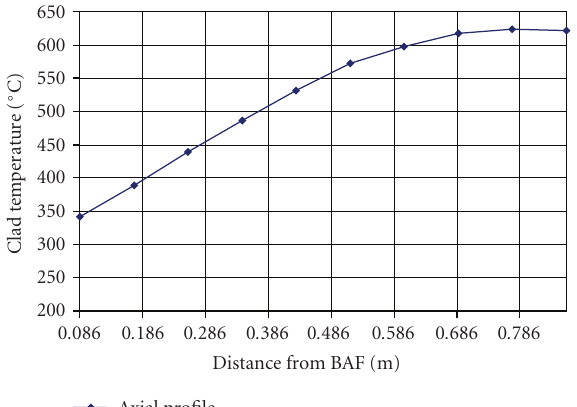
Figure 4: Temperature axial profile—Steady State—Average Chan- nel.